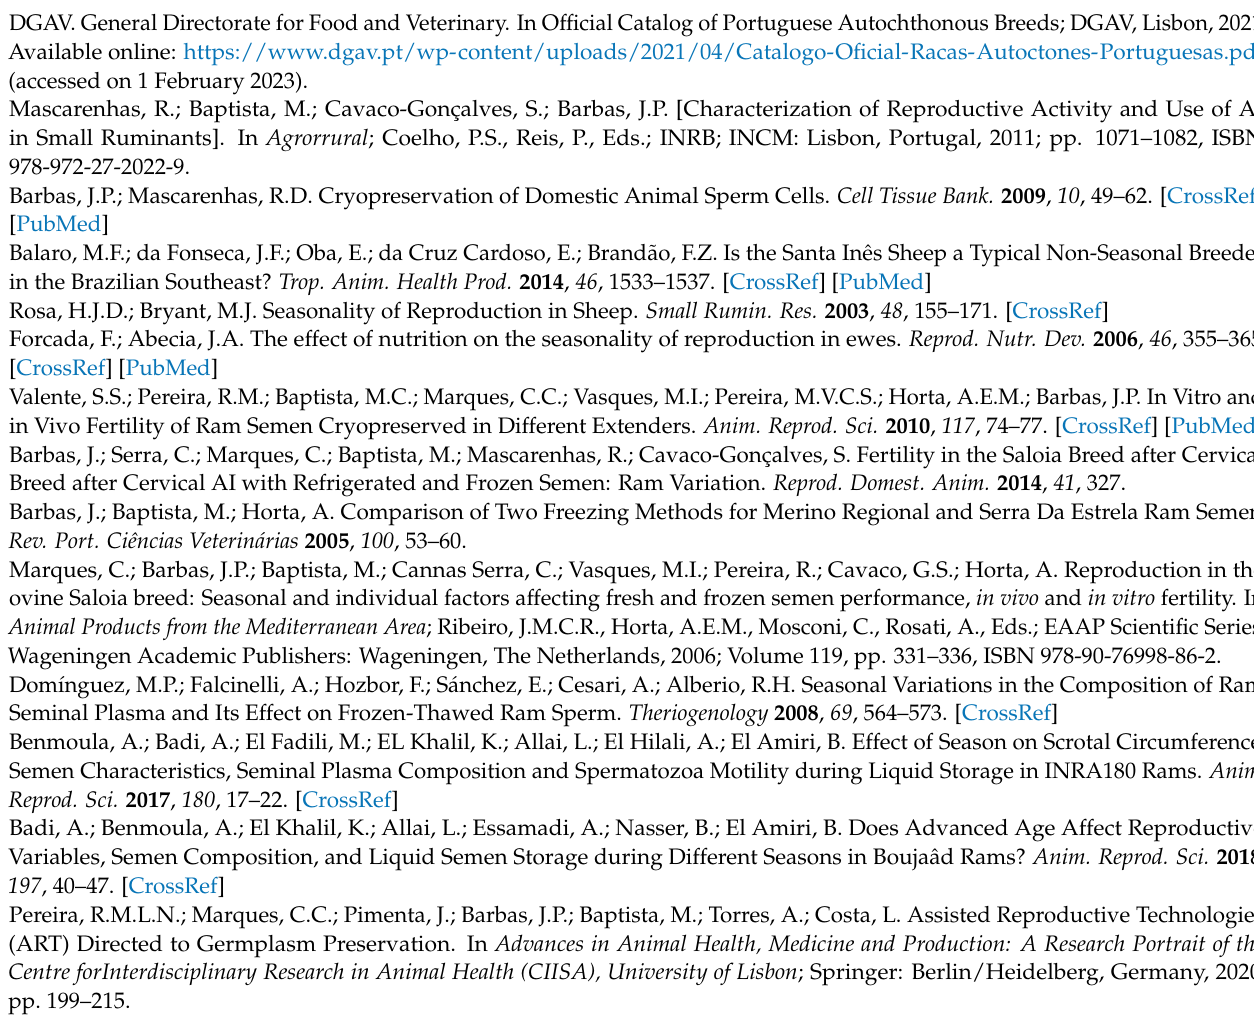
Figure S7. Breed × Thawing interaction on spermatozoa intermediate piece defects; Figure S8. Breed × Season interaction on spermatozoa intermediate piece defects; Figure S9. Breed × Thawing interaction on spermatozoa tail